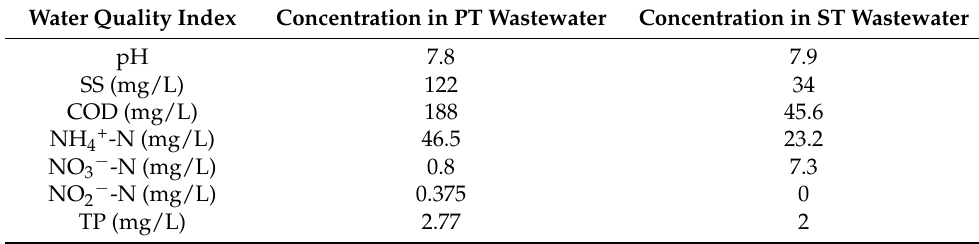
Table 3. The main characteristics of PT wastewater and ST